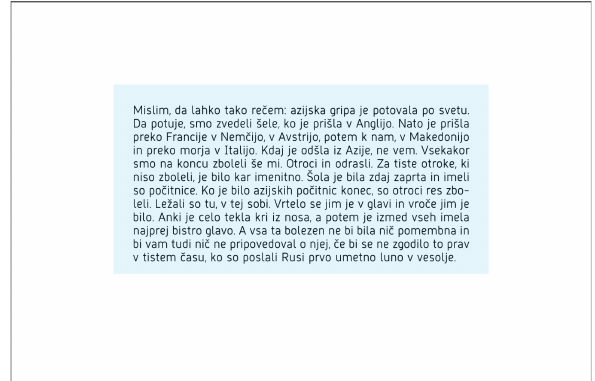
Figure 15. An example of defined ROI.